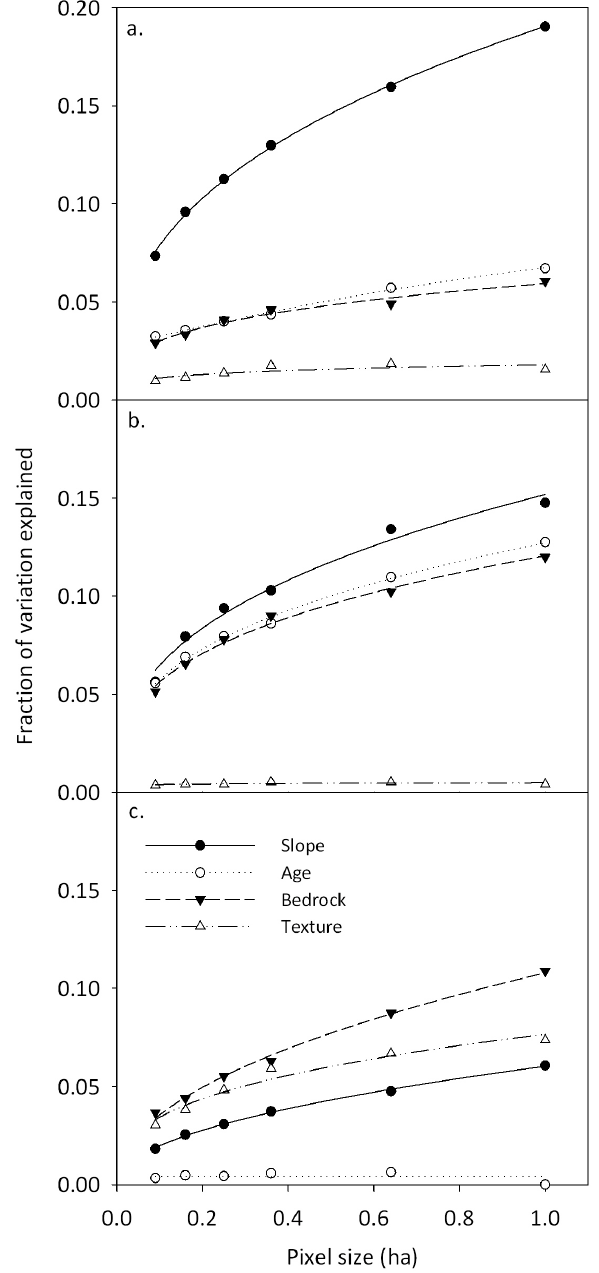
Fig. 5. The proportion of (a) carbon density, (b) mid-canopy den- sity, and (c) low-canopy density variation on BCI explained by model parameters at different spatial resolutions (i.e., pixel sizes). At 1-ha resolution, 33% of the variation in aboveground carbon density is explained by slope, forest age, bedrock type, and soil tex- tural type (F 9 , 1038 = 57 . 7, P < 0 . 0001).